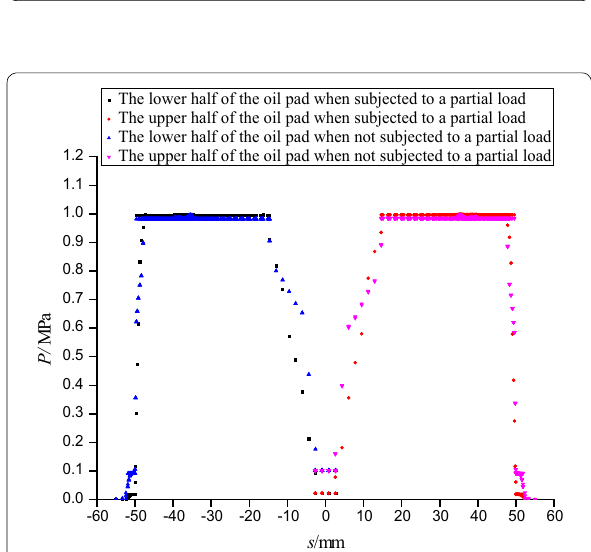
Figure 17 Position-pressure diagram of the central sections of oil pockets with the z -axis as the